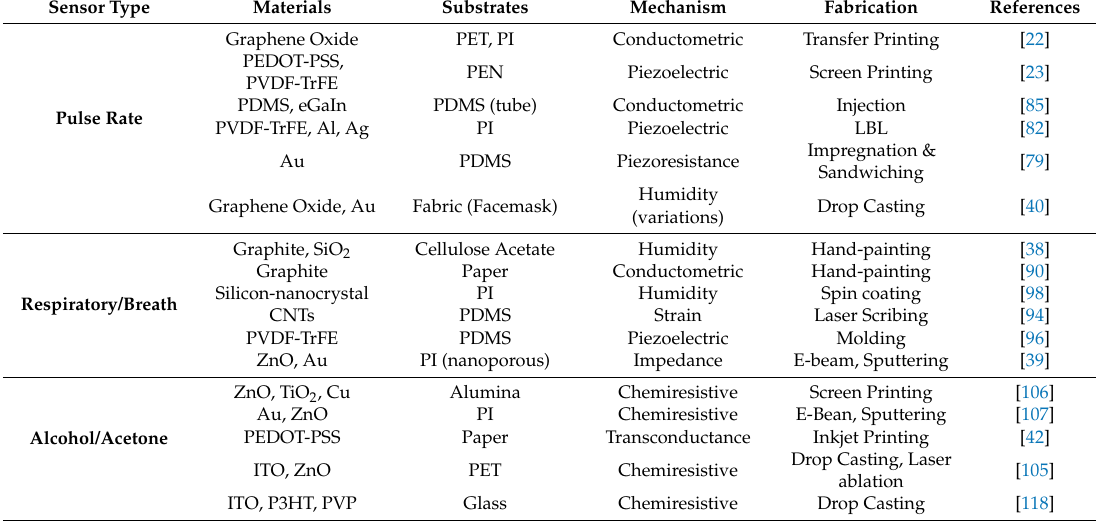
Table 2. Summary of representative materials, substrates, mechanisms, and fabrication